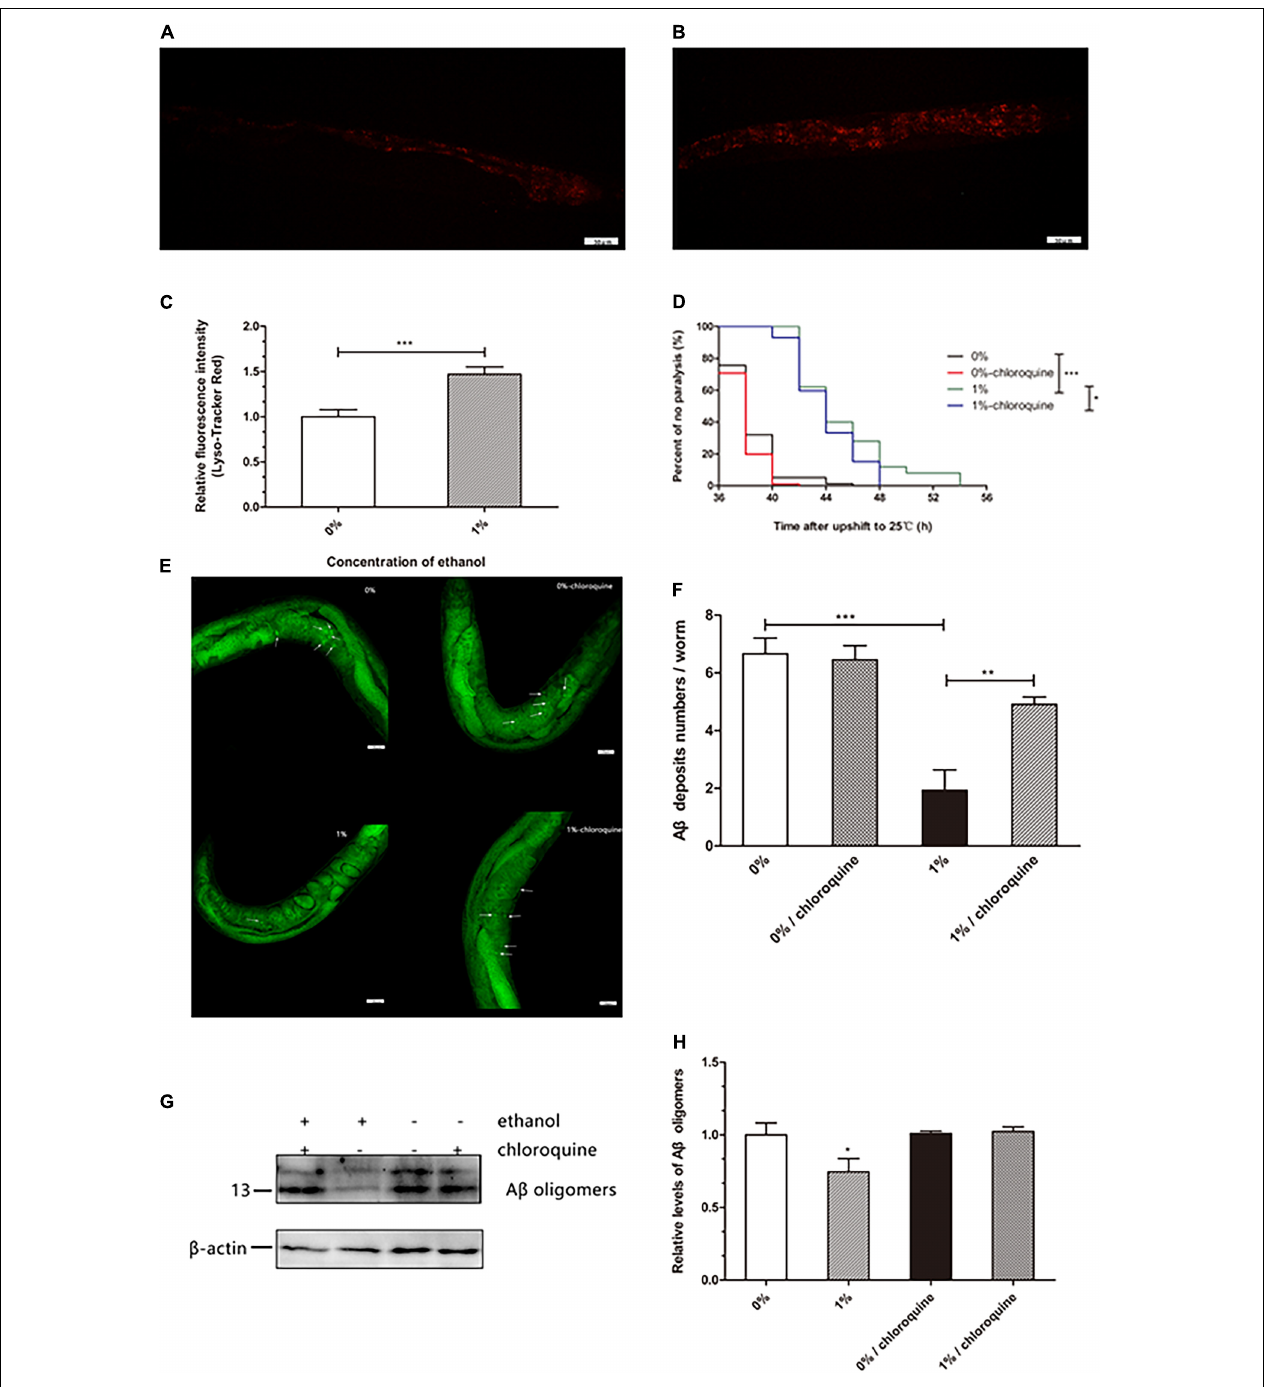
FIGURE 3 | Effect of ethanol on lysosome mass of C. elegans . The measurement of lysosome mass was performed by LysoTracker Red staining. The photo was taken under 20 × objective with a fluorescent microscope. The number of lysosomes is shown by the red fluorescence in the control group (A) and 1% ethanol group, n = 15 (B) . (C) Image J was used to determine the fluorescence intensity of lysosomes. The bar graph shows mean ± SD. (D) Worms were cultured on 1% ethanol or without ethanol NGM agar plates containing 100 µ M chloroquine or without chloroquine. Data represents the paralysis analysis of C. elegans treated with chloroquine, n > 100. (E) A β deposits were measured by Thioflavin T staining, the photo was taken using a 20 × objective with confocal microscopy, n = 15. The arrowheads point out the A β deposits. (F) The number of beta amyloid protein deposits was calculated by mean ± SD. (G) A β oligomers were determined by western blot after worms were fed chloroquine, n = 1,000. (H) The relative level of A β oligomer expression was quantified by Image J software. The bar graph represents mean ± SD. * p < 0.05, ** p < 0.01 and *** p < 0.001.